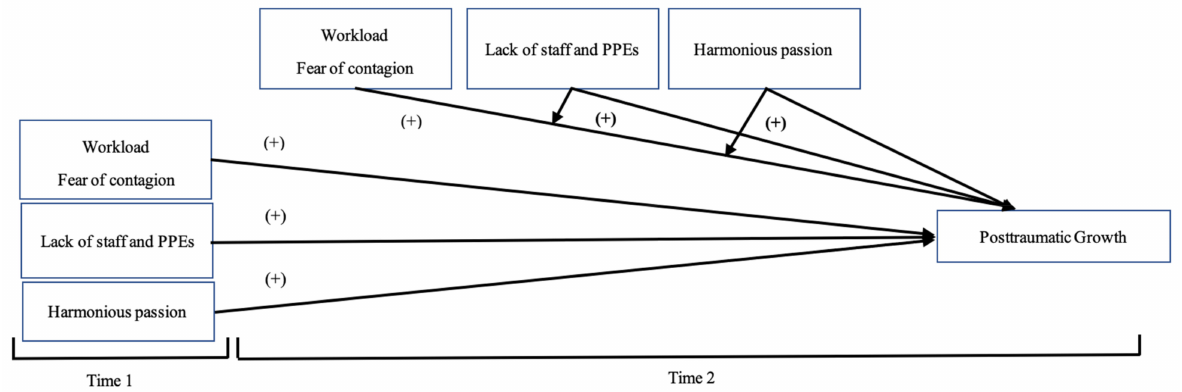
Figure 1. The proposed research model for predicting STS (Secondary Traumatic Stress) in the face of COVID-19.